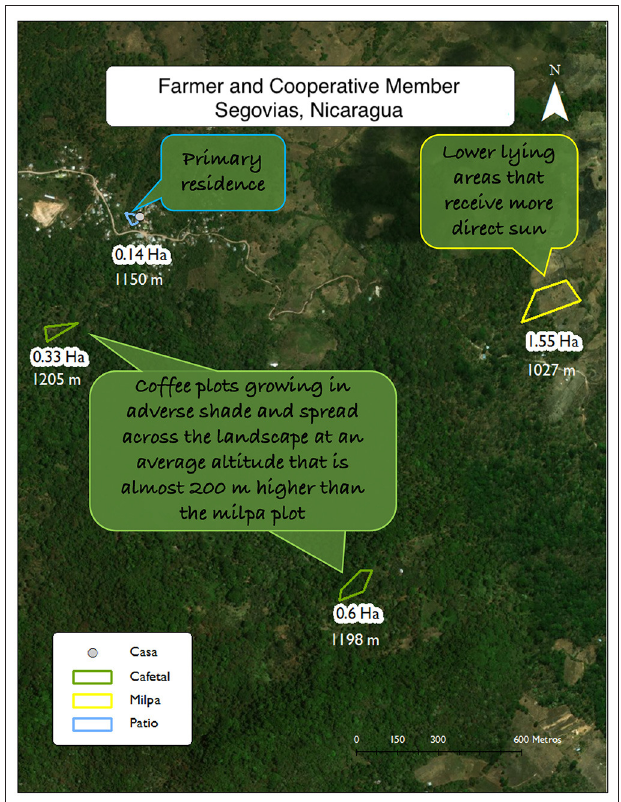
FIGURE 3 | Spatial distribution of productive plots of one farmer in PRODECOOP, Nicaragua.